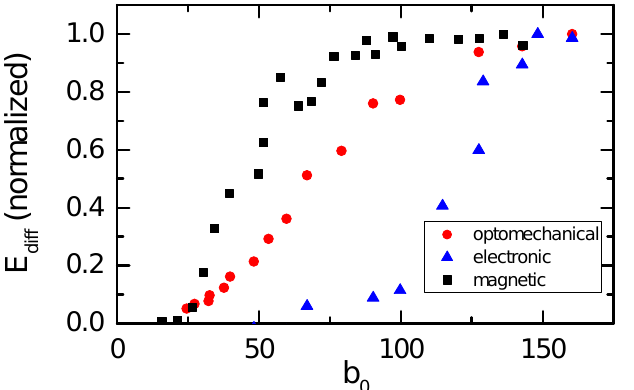
Figure 5. Diffracted energy in sidebands vs. optical density in line centre for optomechanical (red circles), electronic 2-level (blue triangles) and optical pumping nonlinearities (black squares). Each subset of data is normalized to its maximal value. For the optomechanical and electronic case the raw data are from Figure S1 of [44] and pulse duration is used to distinguished between them (see Section 3): short pulses (1 µ s, blue triangles), long pulses (200 µ s, red circles). Parameters: ∆ = + 6 Γ , I = 487mW/cm 2 . Optical density is varied by varying duration of thermal expansion of the cloud by introducing a controlled delay between MOT turn-off and pump pulse. For the optical pumping nonlinearity, parameters are ∆ = − 12 Γ , I = 3.6 mW/cm 2 , pump duration 0.5 ms. The optical density is varied by adjusting the repumper power before the MOT is turned